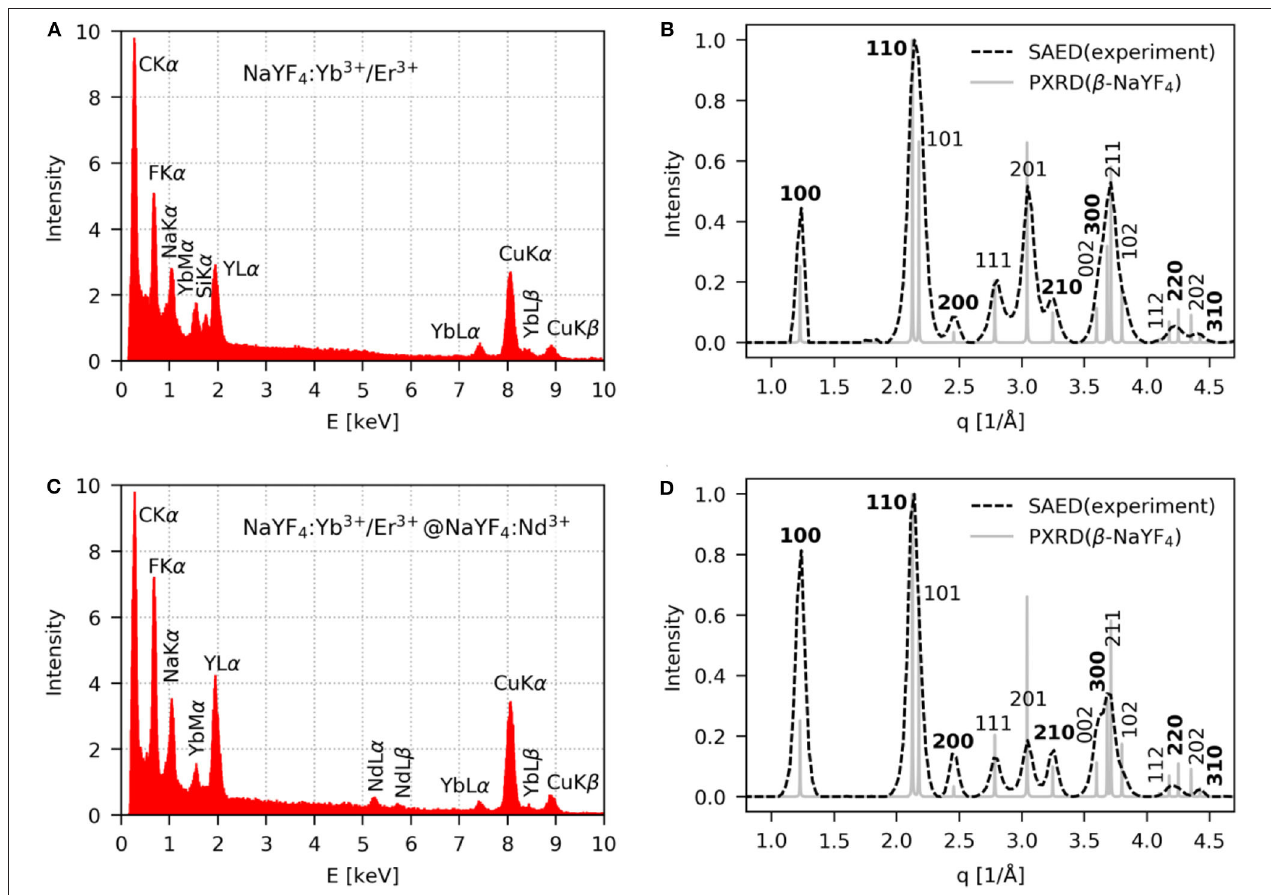
FIGURE 2 | (A,C) TEM/EDX and (B,D) TEM/SAED analysis of (A,B) NaYF 4 :Yb 3 + /Er 3 + and (C,D) NaYF 4 :Yb 3 + /Er 3 + @NaYF 4 :Nd 3 + (0.5 mmol) nanoparticles. Experimental TEM/SAED diffractograms (dashed lines) were compared with theoretically calculated PXRD diffractograms for the hexagonal phase of β -NaYF 4 (full